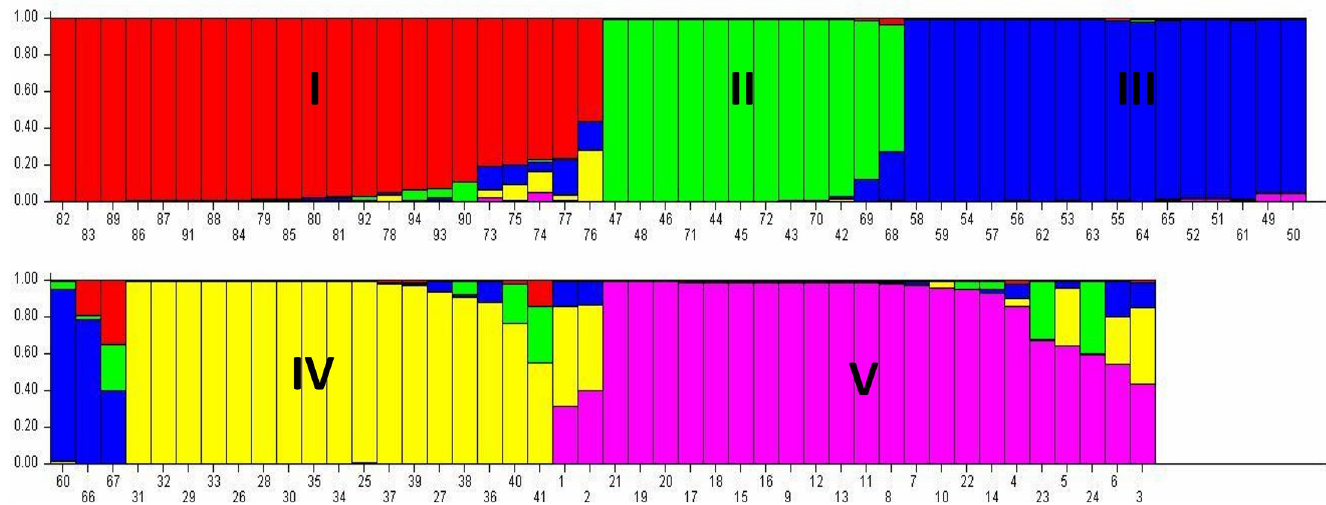
Fig 7. Barplot of population structure (K = 5) of 94 accessions of V . stipulacea based on 33 SSRs. Each individual bar represents an accession. The serial number of the V . stipulacea accessions in the barplot follows Table 1.